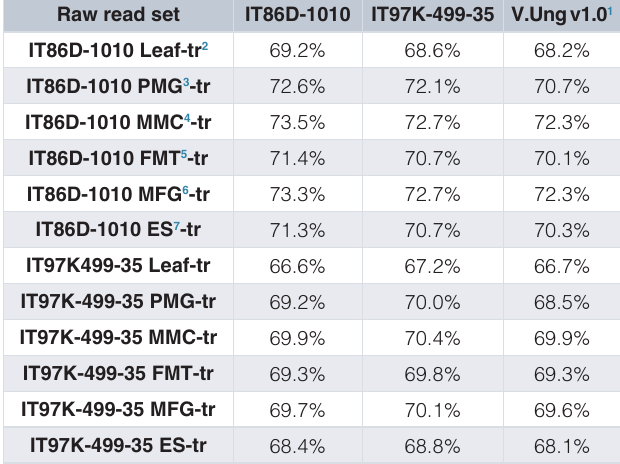
(Table 8) showed expression and 6% of predicted gene models displayed strong tissue-specific expression. We found that on average 90% of IT86D-1010 transcript contigs could be mapped within a IT86D-1010 genomic contig and that the median